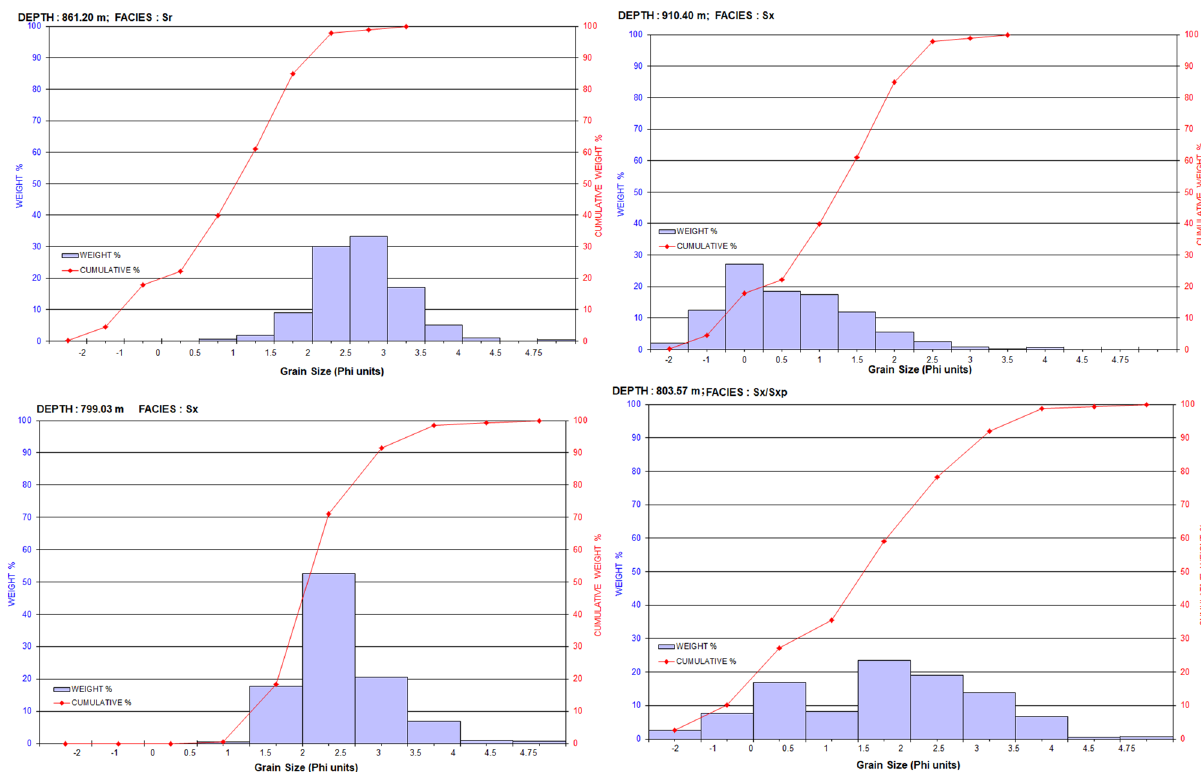
Figure 6. Representative, grain size and sieve analyses histograms showing cumulative weight percentage and grain size